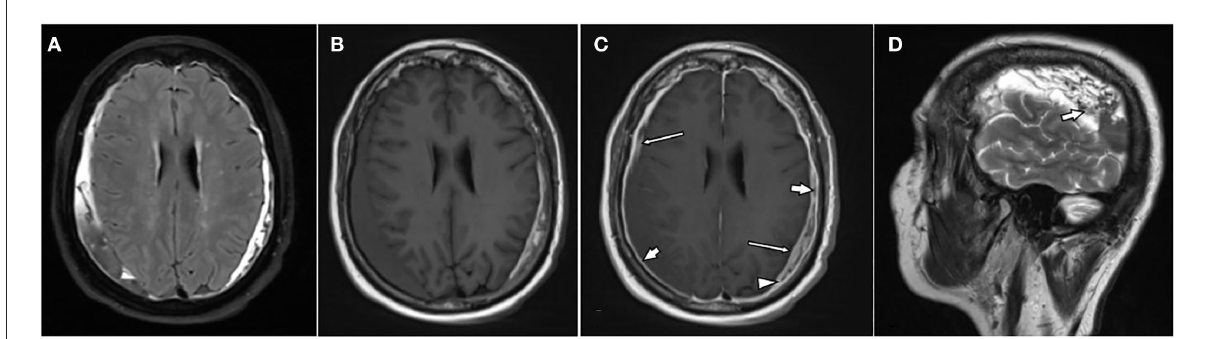
FIGURE3 A 76-year-old female patient with bilateral chronic subdural hematomas (cSDHs). Axial-T2-FLAIR image (A) , axial T1w images pre (B) , post (C) , and contrast administration as well as a sagittal T2w over the right hematoma (D) . The hematomas are of mixed signal intensity on T2-FLAIR (A) , T1w (B) , as well as T2w images [ (D) : arrow]. There is enhancement of the inner [ (C) : thin arrows] and outer membrane [ (C) : arrows] as well as spandrel-like contrast enhancement at the borders of the hematoma [ (C) : arrowhead].